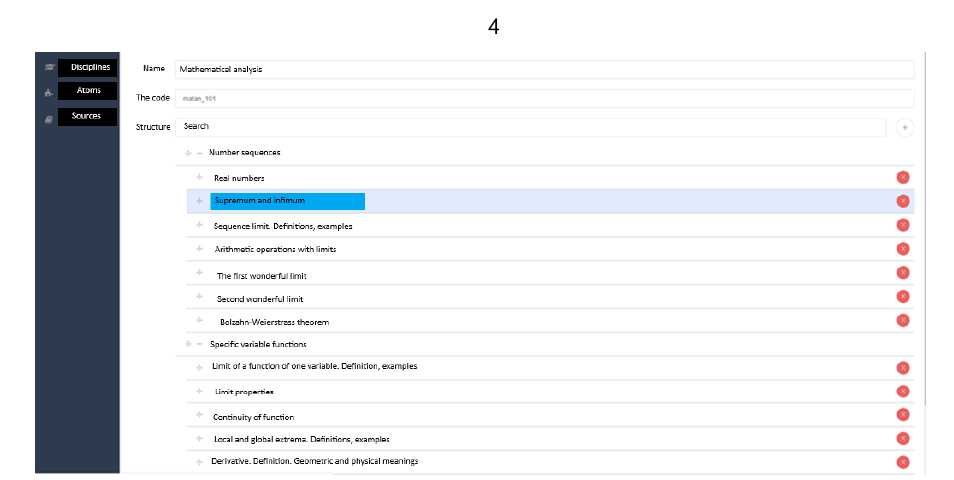
Fig. 4. Course structure example.